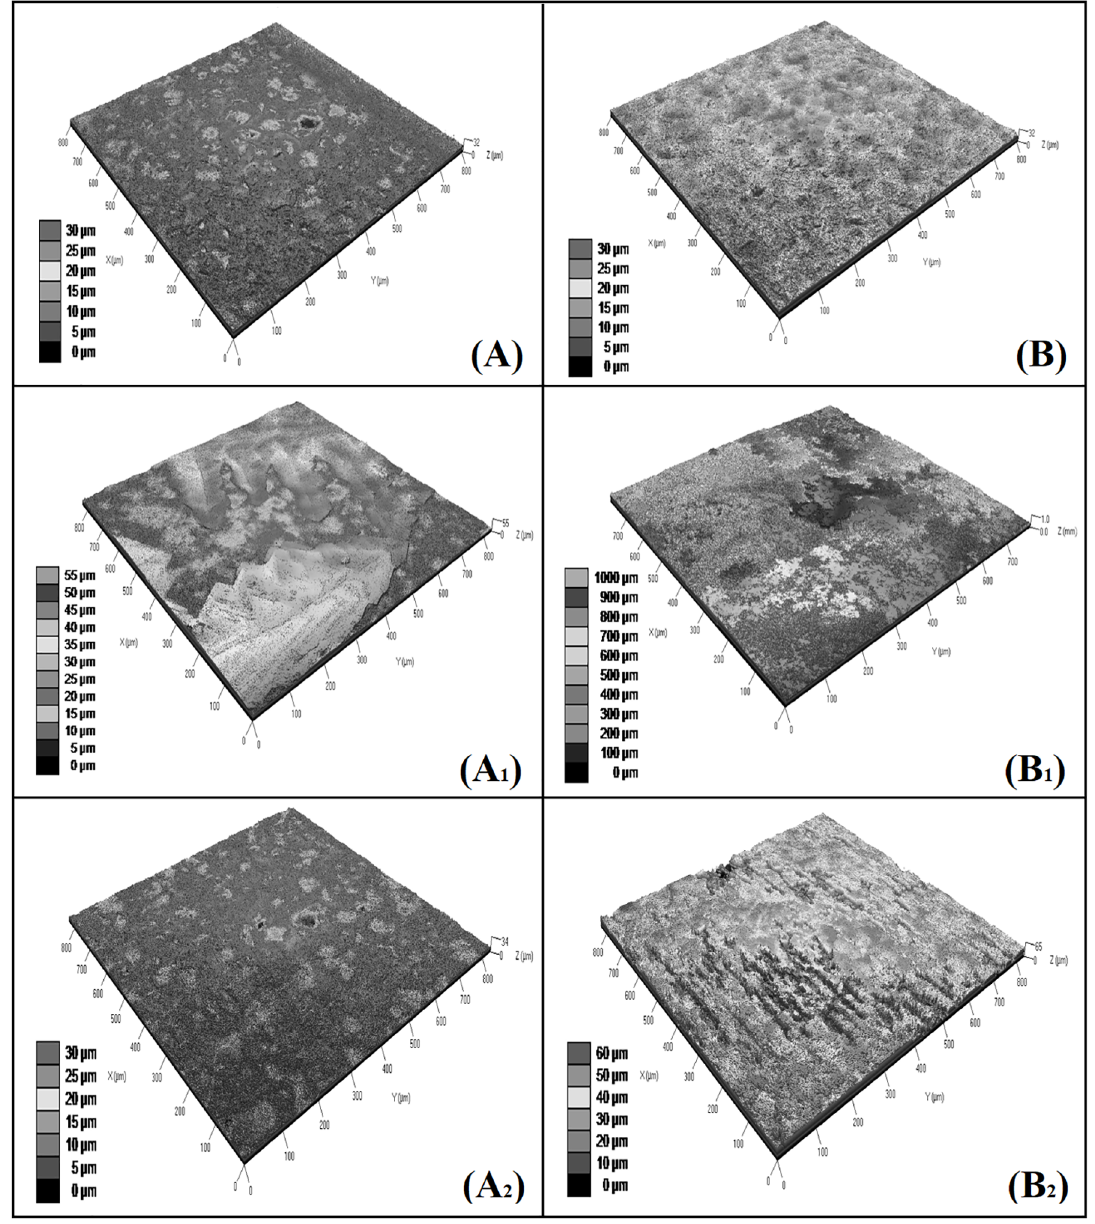
Figure 4. 3D topographies of API 5L X80 steel coupons. (A) abiotic before exposure, (A1) abiotic after exposure with film, (A2) abiotic after exposure without film, (B) biotic before exposure, (B1) biotic after exposure with biofilm and (B2) biotic after exposure without